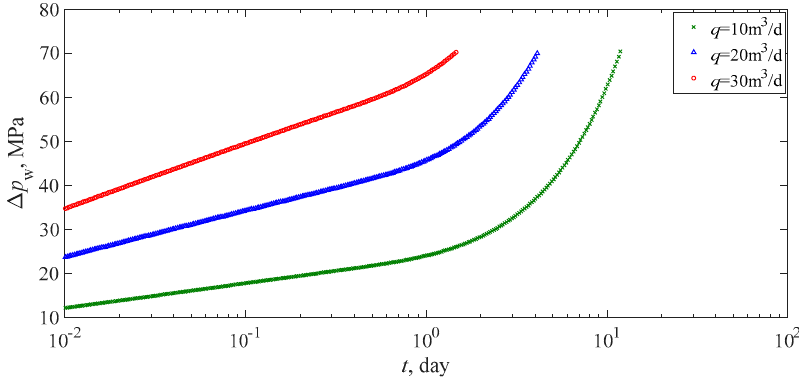
Figure 11. Production data for CRP cases with different values of flow rate q .